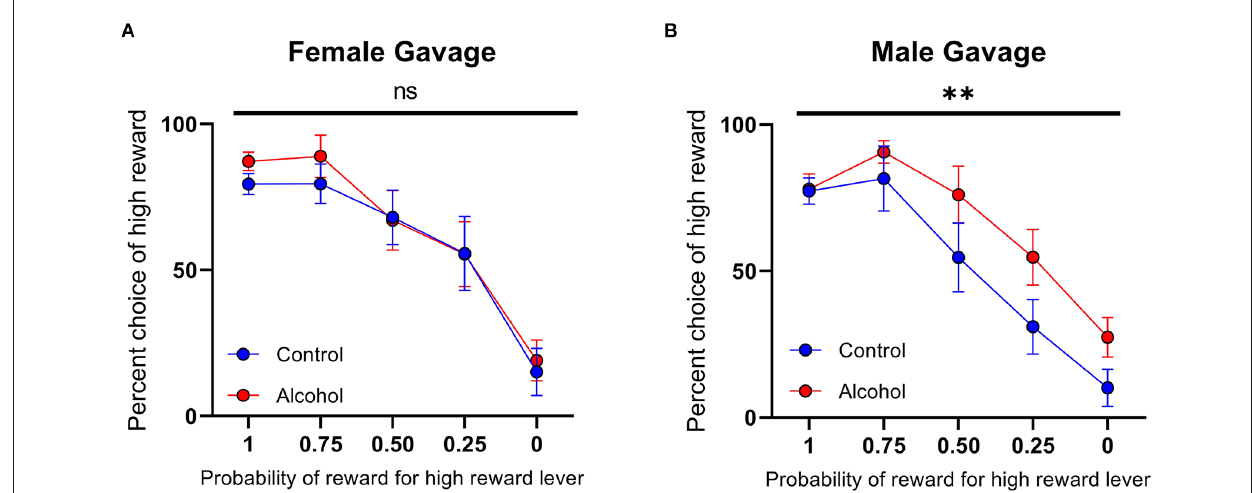
FIGURE6 Psychometric functions for males and females receiving alcohol or vehicle via intragastric (IG). (A) Alcohol-exposed ( n = 10) and control ( n = 8) female animals did not differ in choice behavior over the probability of reward for high reward lever or in total reinforcements received. (B) Alcohol- exposed ( n = 8) and control ( n = 7) male animals did significantly differ in choice behavior over the probability of reward for high reward lever, but not in total reinforcements received. All data are presented as mean ± SEM for the percent of high choice reward according to the probability of reward for high reward lever of 1.00, 0.75, 0.50, 0.25, and 0.00. ∗∗ p > 0.01, ns p >